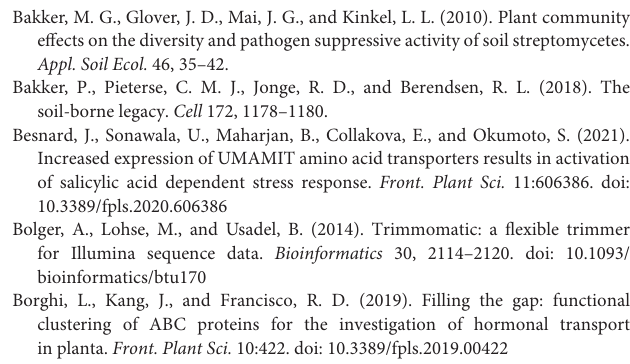
Supplementary Figure 1 | Alpha diversity dilution curves. Each group contained six samples. The abscissa is the total number of sequences, while the ordinate represents the number of OTUs. (A) Healthy and disease rhizosphere soil chao1 alpha diversity dilution curves. (B) Healthy and disease rhizosphere soil observed alpha diversity dilution curves. (C) Healthy and disease root endophyte chao1 alpha diversity dilution curves. (D) Healthy and disease root endophyte observed alpha diversity dilution curves. Supplementary Figure 2 | Boxplots of diversity in the rhizosphere soil and root endophyte group. (A) ACE index box plot based on the rhizosphere soil and root endophyte bacteria species abundance. (B) Chao1 index box plot based on the rhizosphere soil and root endophyte bacteria species abundance. (C) Invsimpson index box plot based on the rhizosphere soil and root endophyte bacteria species abundance. (D) Simpson index box plot based on the rhizosphere soil and root endophyte bacteria species abundance. Supplementary Figure 3 | Annotation results of bacteria with significantly different functional descriptions. (A) Amino acid transport and metabolism, cell motility, posttranslational modification, protein turnover, and chaperones, and unknown function. (B) Antibiotic gene percentage of each group. (C) Venn diagram of KEGG orthologs (KO) functional annotation results for each group. Supplementary Figure 4 | Quantitative heat map of the bins in each group. (A) Quantitative heat map of the bins in healthy rhizosphere soil. (B) Quantitative heat map of the bins in disease rhizosphere soil. (C) Quantitative heat map of the bins in healthy root endophyte. (D) Quantitative heat map of the bins in disease root endophyte. Supplementary Figure 5 | Vitro infection results of Pseudomonas fluorescens . Supplementary Table 1 | Sample and data information. Supplementary Table 2 | Eukaryote information for each sample. Supplementary Table 3 | Function annotation information. Supplementary Table 4 | Genomic and classification information of the bins in each